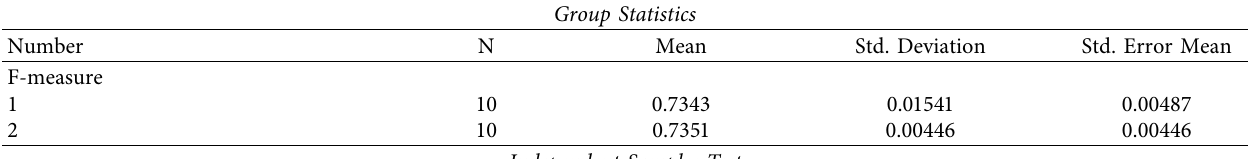
Table 7: The t -test on the Collins sample (CYC2008 reference clusters).